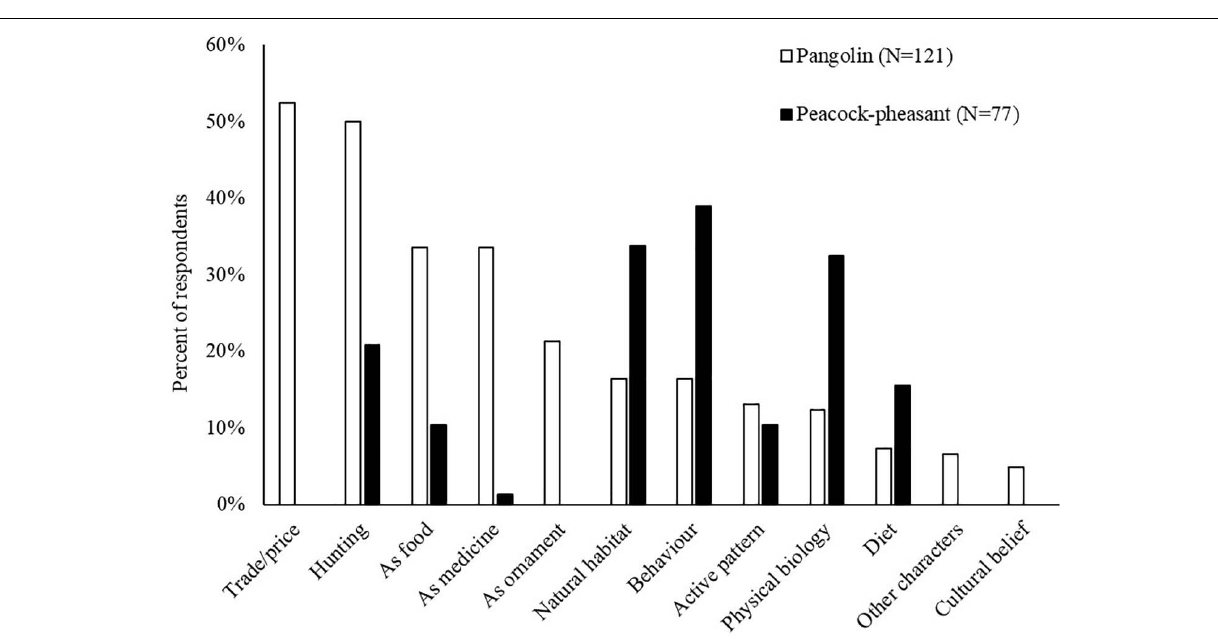
half of the 20th century; 49 out of 121 interviewees ( >